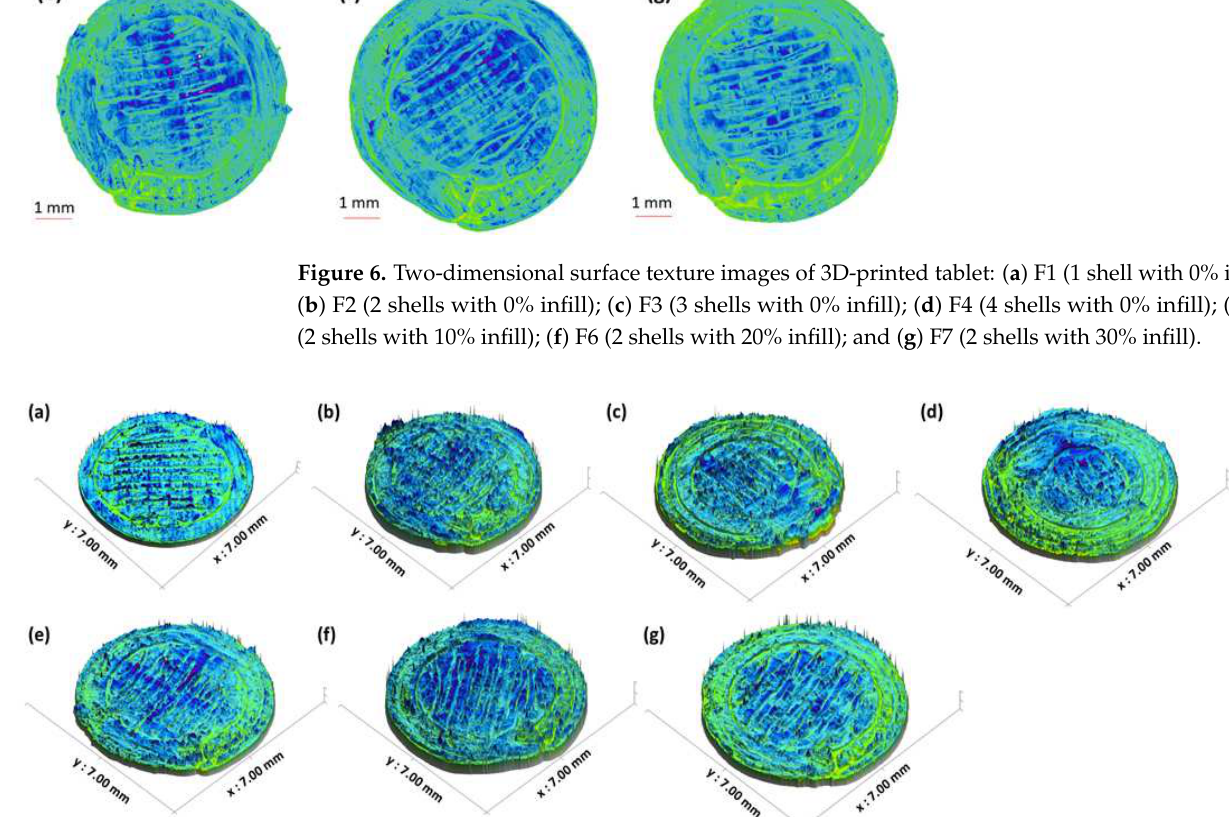
Figure 8. Surface roughness properties of 3D-printed tablets, showing the effect of ( a ) shell number and ( b ) infill percentage (n = 5). F1 (1 shell with 0% infill); F2 (2 shells with 0% infill); F3 (3 shells with 0% infill); F4 (4 shells with 0% infill); F5 (2 shells with 10% infill); F6 (2 shells with 20% infill); and F7 (2 shells with 30% infill). 2.3. Ex Vivo Mucoadhesion Studies Mucoadhesion is the interaction between the pharmaceutical dosage form and the mucus membranes enabling a better contact between the formulations and membranes to prolong the residence time [55]. The process involves the wetting and hydration of the polymer, which is known as the contact stage and is essential in developing the mucoad- hesive interaction. The next stage consists of interpenetration between mucosal membrane and polymeric chains, forming a chemical bond due to the hydrogen bonding, van der Waals, or electrostatic interaction [56]. These surface forces result in adhering the sub- stance to the mucosal membrane. PEO consists of long and linear chains of ethylene oxide. At a low molecular weight, PEO possesses very weak mucoadhesive properties, i.e., forms weaker gels with mucus, which, may be, is due to the less available sites for hydrogen bonding or conformation for interpenetration between polymeric chains and the mucosal membrane is not favourable. Therefore, high concentrations of low-molecular-weight PEO are required to detect any mucoadhesion. However, on the other hand, PEO with